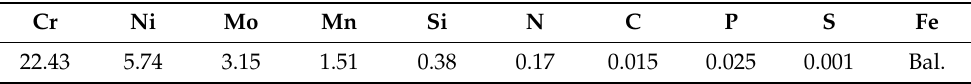
Table 1. Chemical composition of the 2205 DSS base material (in wt.%).